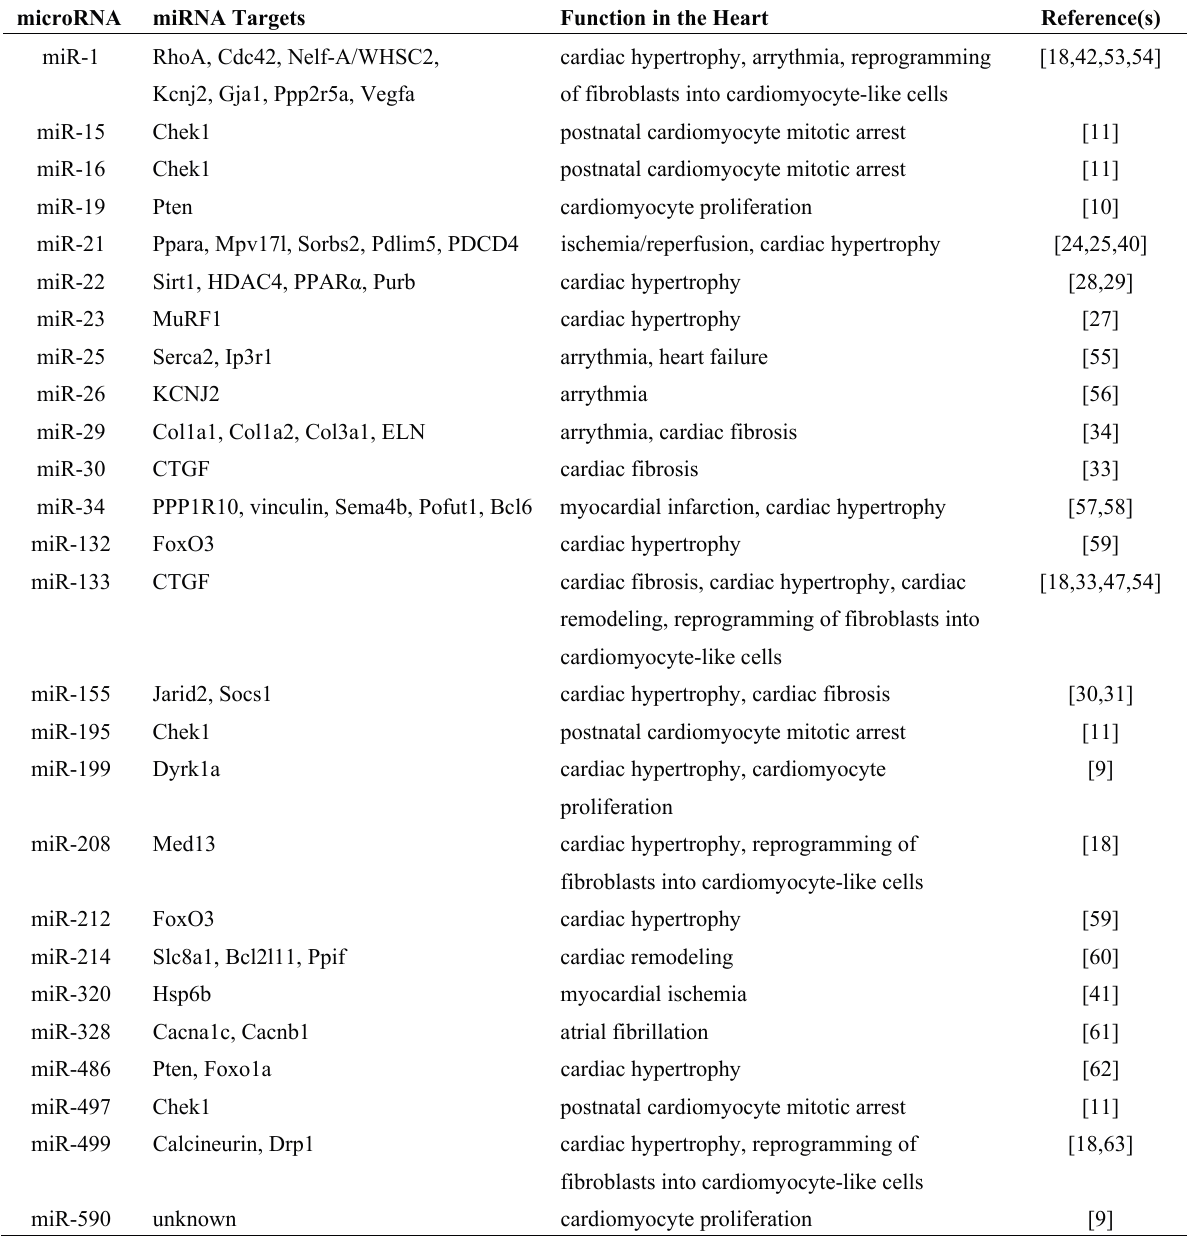
Table 1. miRNAs and their targets implicated in the function of the